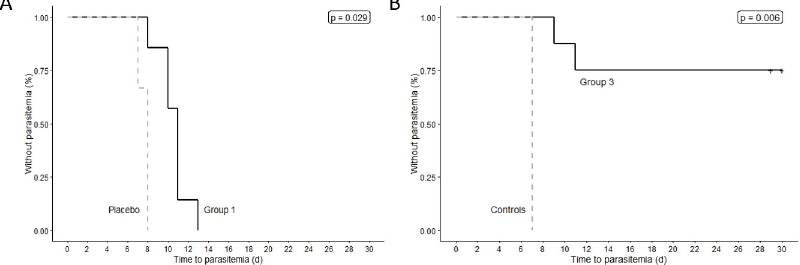
Fig 4. Kaplan-Meier curves for time to first P . falciparum qRT-PCR positive after CHMI in vaccinated subjects versus placebo or control subjects in Groups 1 and 3. ( A ) Group 1 (seven-day interval vaccine cohort, n = 9) and control (n = 3) data. ( B ) Group 3 (five-day interval vaccine cohort, n = 9) and control (n = 3) data. qRT-PCR limit of detection, 20 estimated parasites/mL. p values calculated using log-rank test.